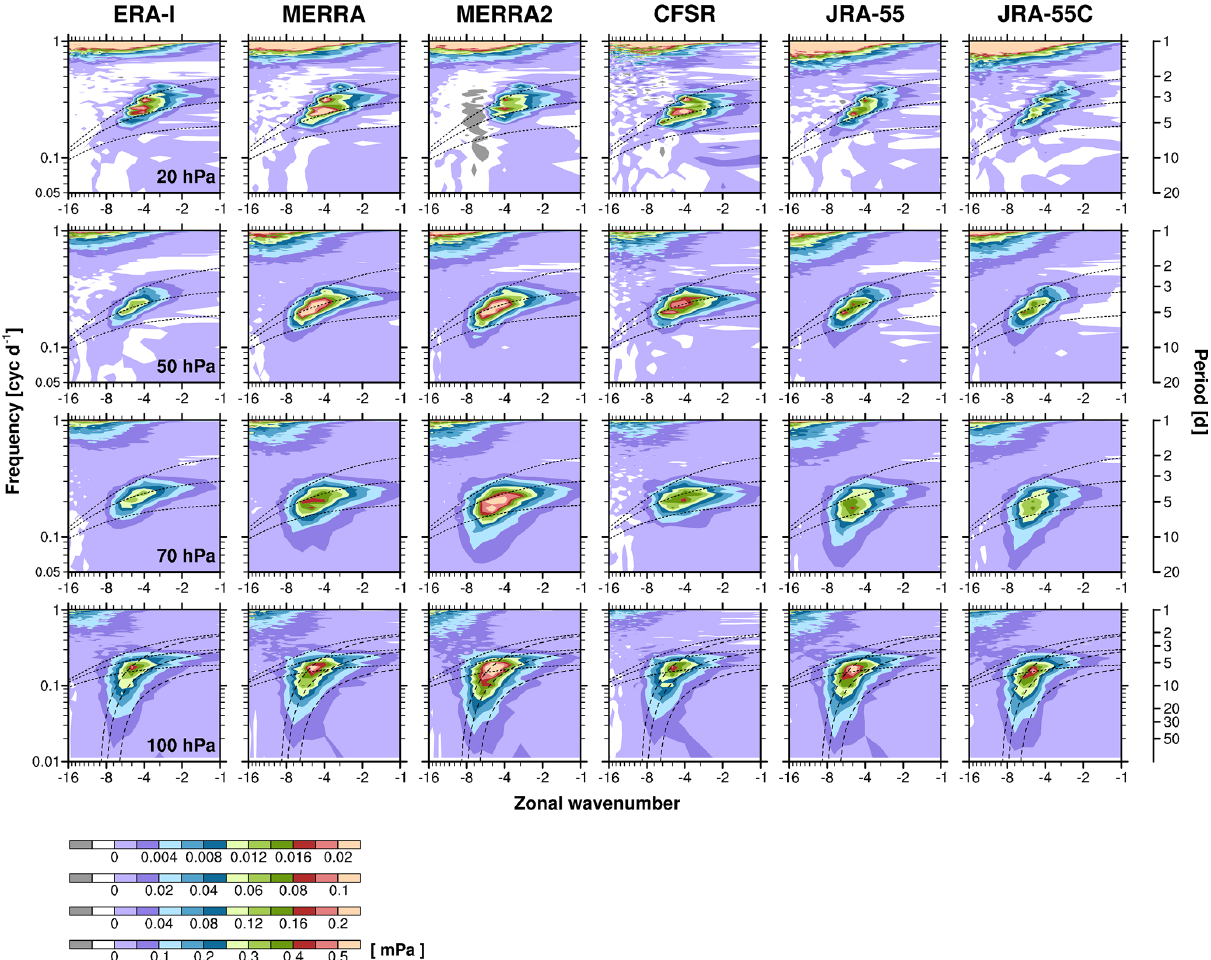
Figure 10. The same as in Fig. 9 but for F z of antisymmetric modes. The MRG wave dispersion curves for the windless background state are indicated by the dotted lines for h = 8, 60, and 480m. At 100hPa, the dispersion curves for the background zonal wind of + 10ms − 1 are also indicated by the long-dashed